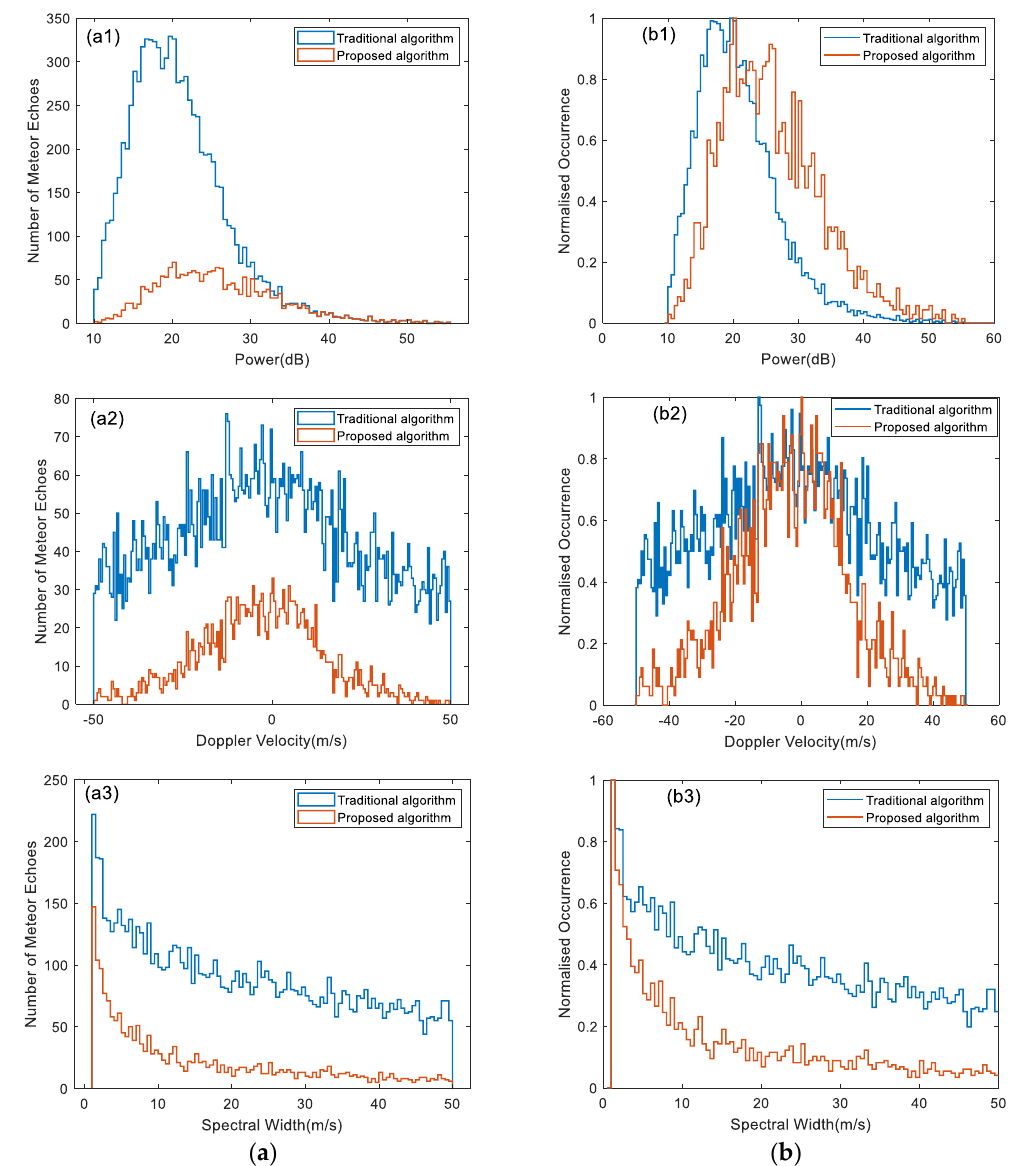
Figure 6. Comparison histogram of meteor echo extracted by the proposed algorithm and the traditional algorithm. ( a1 ) Backscatter power distribution, ( a2 ) LOS Doppler velocity distribution, ( a3 ) Spectral width distribution, ( b1 ) Normalized power distribution, ( b2 ) Normalized Doppler velocity distribution, ( b3 ) Normalized Spectral width distribution.